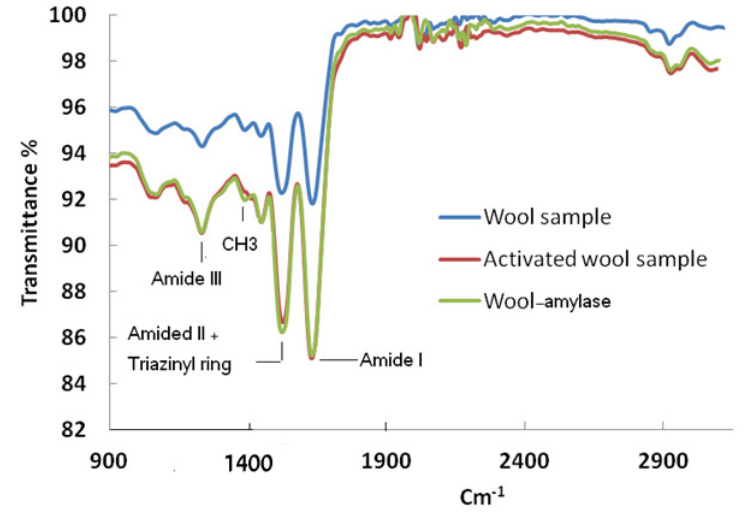
Figure 3. FT-IR spectra of the wool sample, the activated wool sample and the immobilized wool- α -amylase sample.